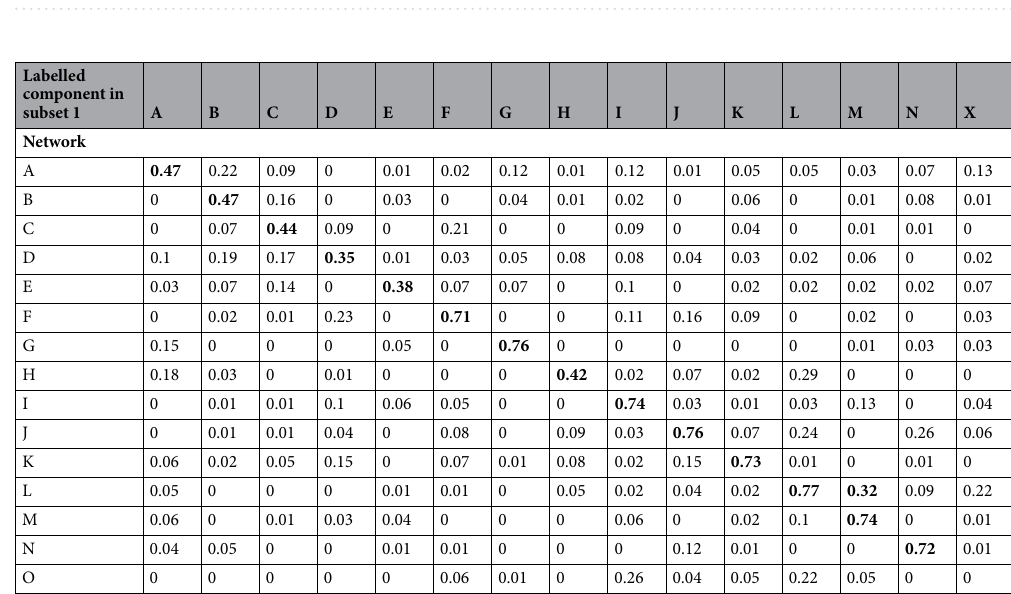
Figure 19. Components from the 10 component gICA. Thresholded T-maps, corrected for multiple comparisons, overlaid on the Nitzsche atlas 15 .